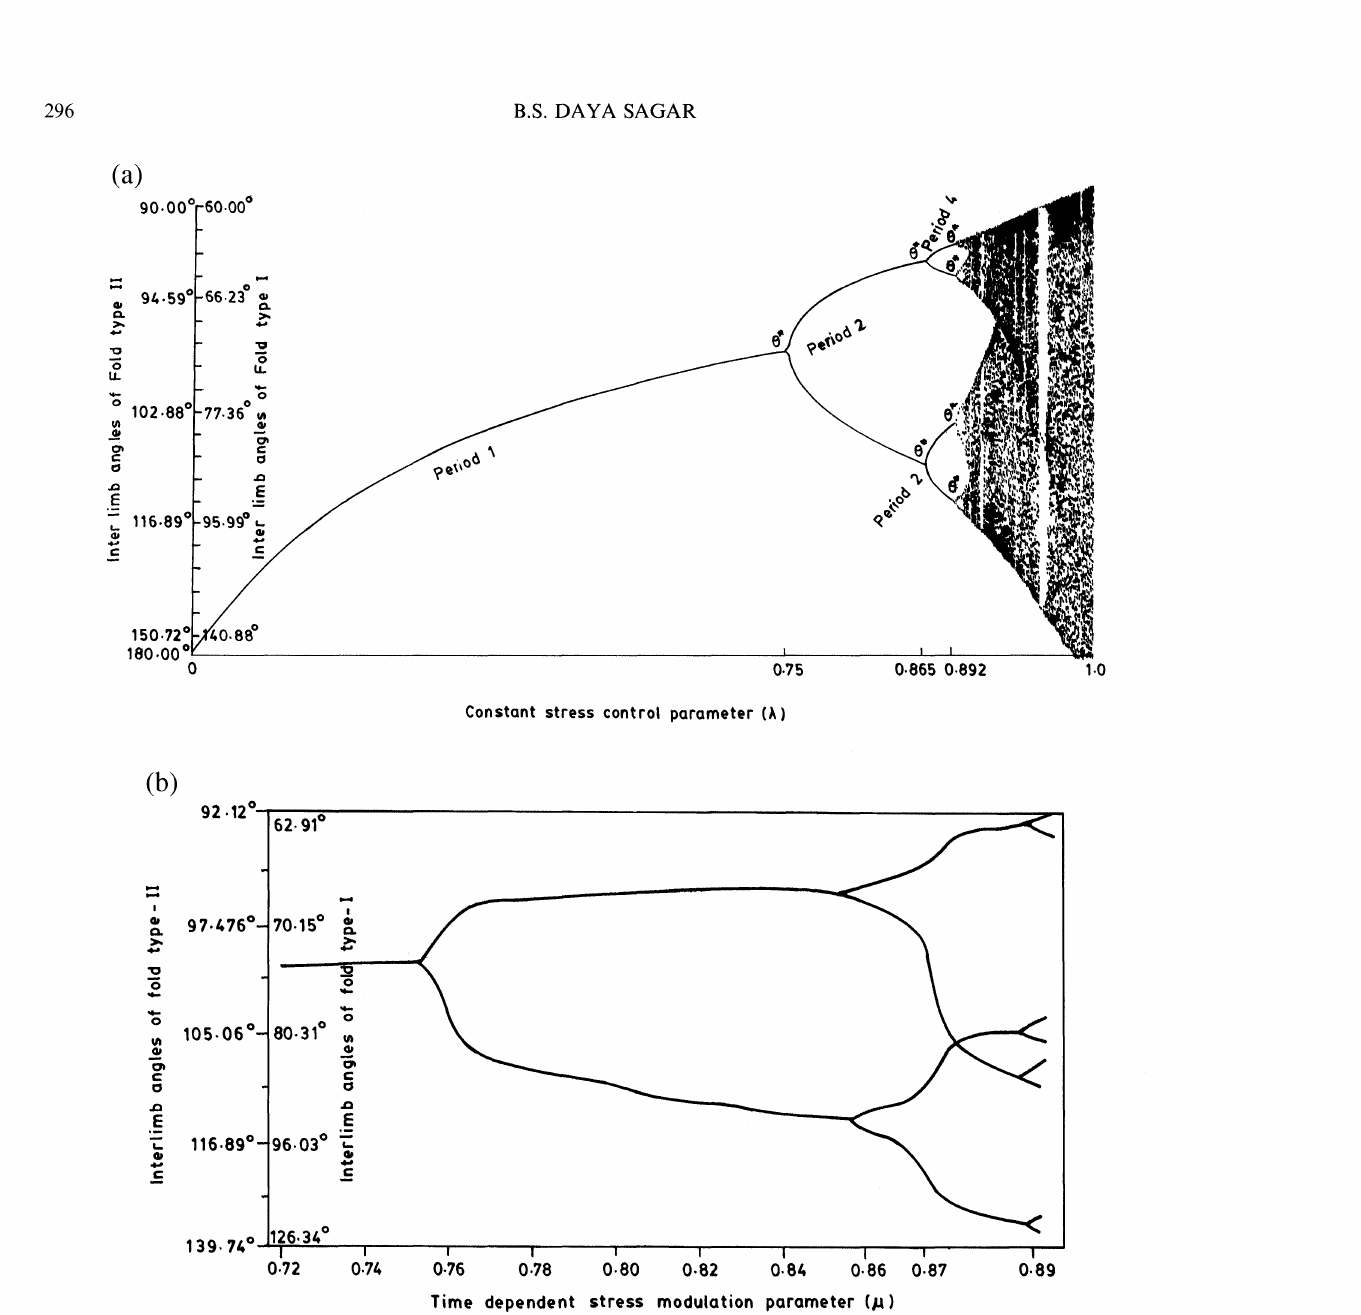
, FIGURE 7 (a) Bifurcation diagram showing various possibilities of fold transformations: stable, unstable, chaotic. The value of measures the constant strength of stress regulatory parameter which controls the fold. The evolution of the fold system can be , segregated as period zero, period one, period two, and chaotic. Period zero: A contorted fold with ct=0.06363 becomes straight , when ct+ approaches zero, is between 0 and 0.25. This is possible under the process of continuous fold amplification. Period is between 0.25 and 0.75, the fold pattern shortens, and the pattern reaches a fixed point attractor. It means that one: When the fold reaches the equilibrium state. Period two: The fold pattern oscillates between two points when A is between 0.75 and 0.89225. The fold amplification and compression will occur periodically. Chaotic: The behavior of fold is such that the fold shapes at different time periods do not overlap. Here, the fold amplification and compressions may occur, as time progresses, randomly. The values on both sides of the Y-axis represent the IAs of the symmetric folds with three limbs and two limbs respectively. (b) Bifurcation diagram of Eq. (11) that describes the fold dynamics under the influence of time dependent stress regulatory parameter. The branches crossing over each other in the 4-cycle region result in a complete modification of the